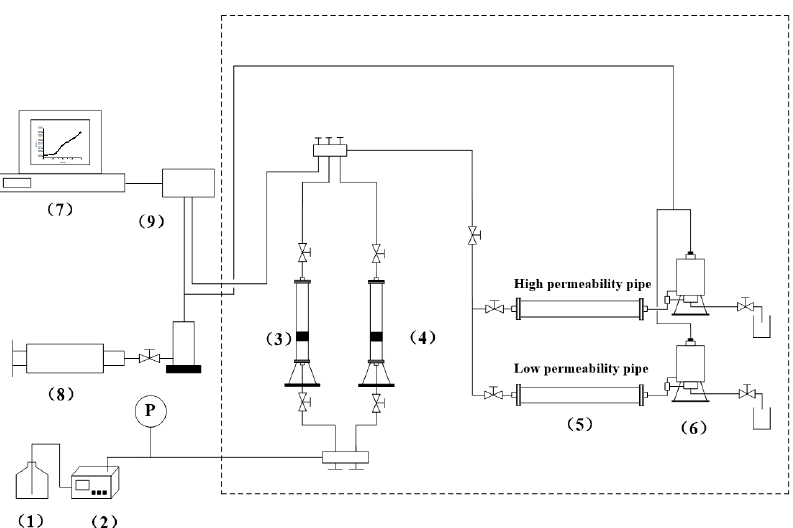
Figure 3. Flow chart of the plugging experiment for different heterogeneous formations of the plugging agent. (1) Distilled water tank; (2) horizontal flow pump; (3) strata water tank; (4) plugging agent material tank; (5) sand filling pipe; (6) back-pressure valve; (7) computer; (8) back pressure pump; (9) pressure sensor.